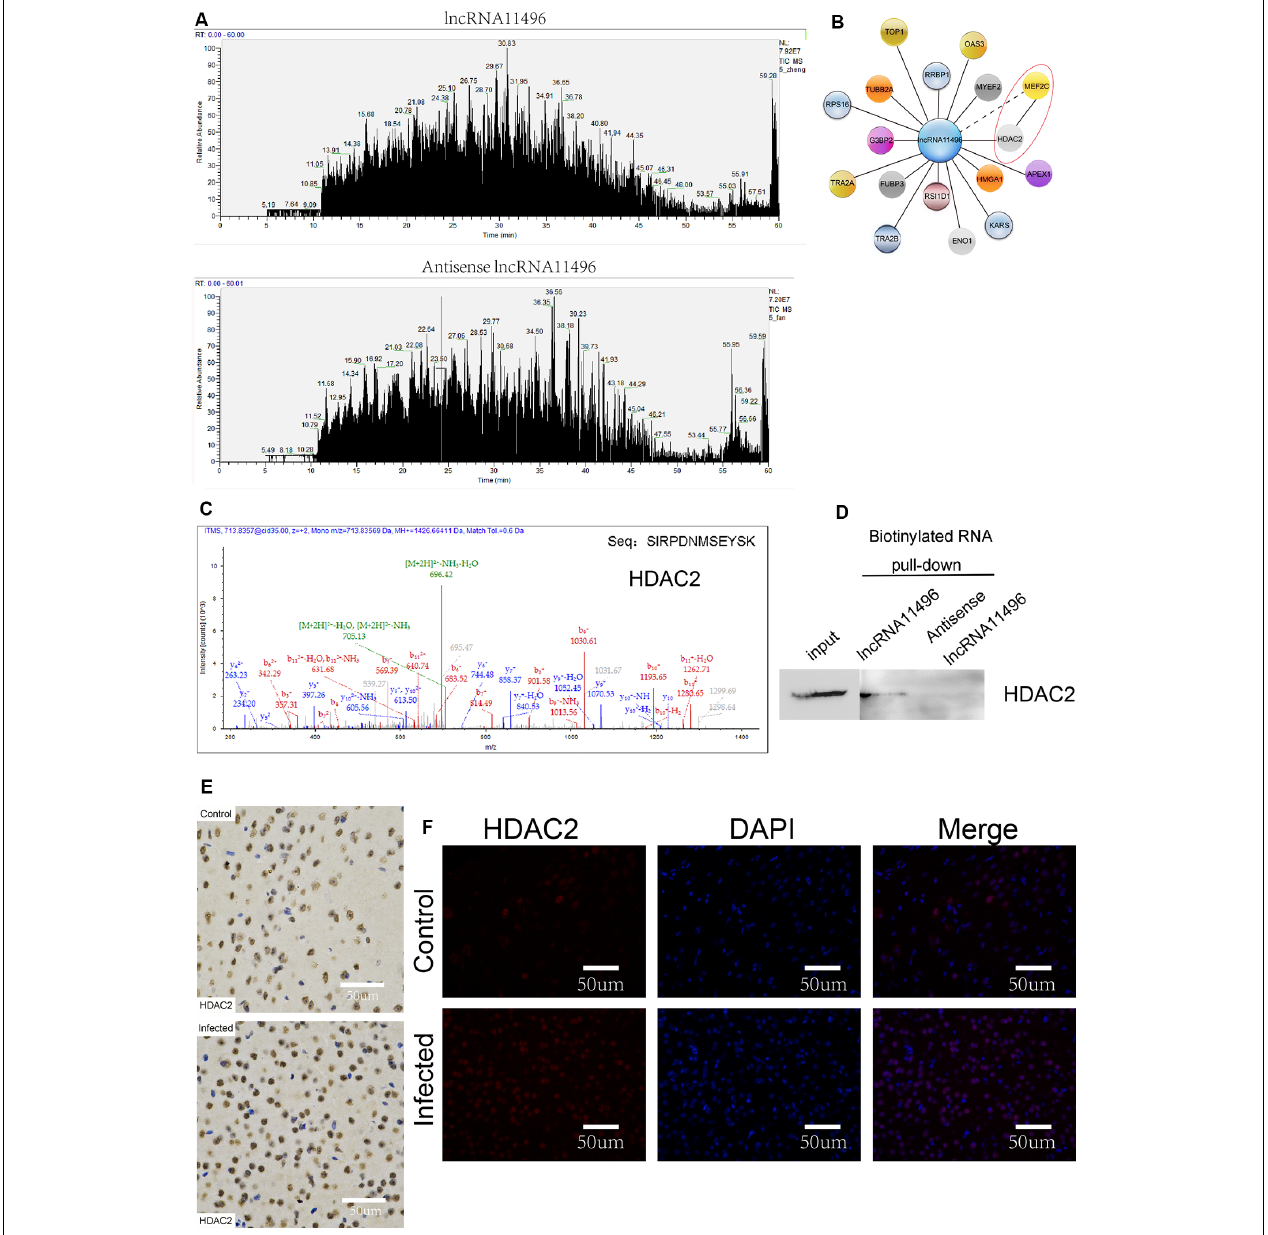
FIGURE 7 | lncRNA11496 regulates the expression of MEF2C by binding to HDAC2 in chronic T. gondii infected mouse brain. (A) Mass spectrometry shows the proteins that are pulled down by lncRNA11496 and its antisense. (B) STRING analysis shows MEF2C could interact with HDAC2. (C) Mass spectrometry identified HDAC2 could bind to lncRNA11496. (D) The protein that was pulled down by lncRNA11496 was confirmed to be HDAC2. by Western blot. (E) Immunohistochemical analysis of HDAC2 expression in the brains of mice infected or uninfected with T. gondii . The slice derived from brain was subsequently subjected to rabbit anti- HDAC2 antibody and HRP Goat Anti-Rabbit IgG, and then nucleus stained with hematoxylin staining solution. HDAC2 protein shows in yellow color. (F) Immunofluorescence analysis of HDAC2 expression in the brains of mice infected or uninfected with T. gondii . The slice derived from brain was subjected to immunofluorescence with the primary antibody against HDAC2 (red). DAPI (blue) was used for